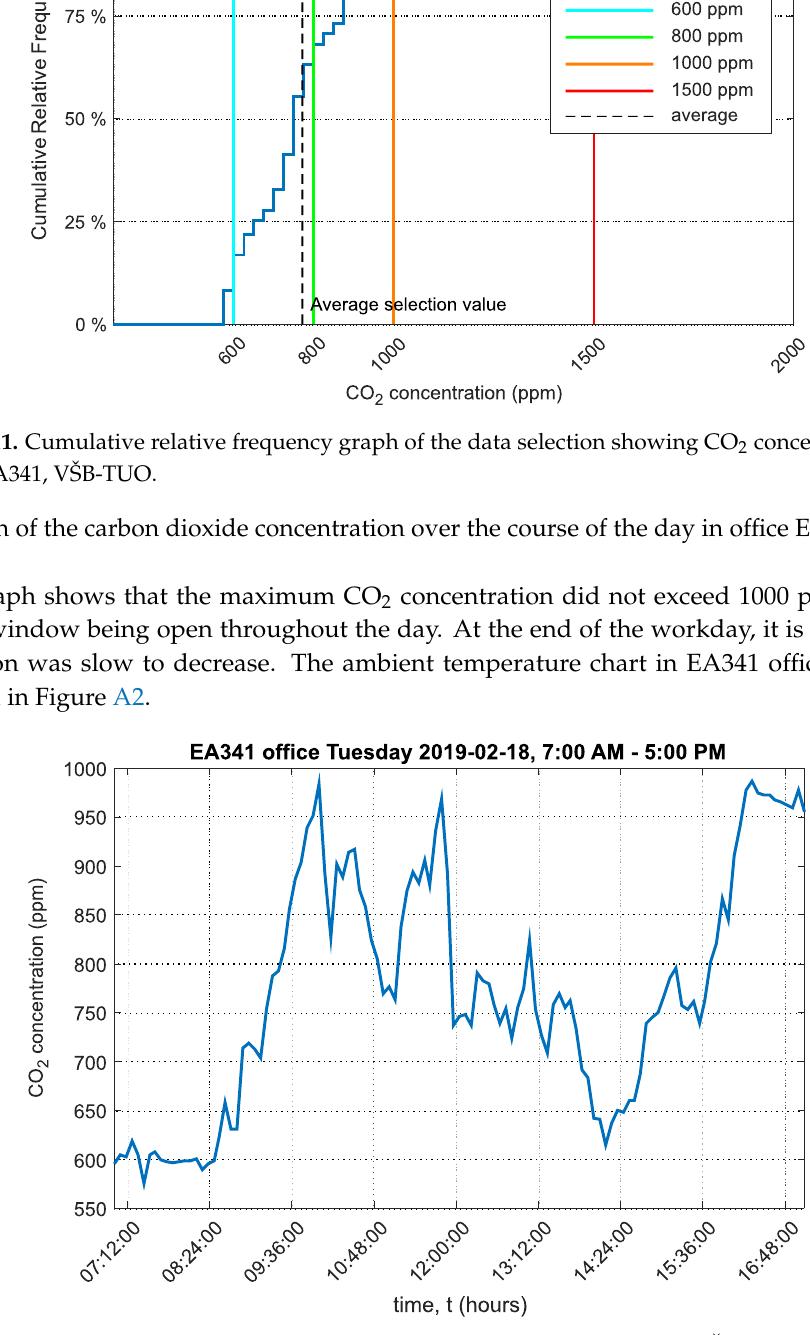
Figure 12. Graph of carbon dioxide concentration in office EA341,